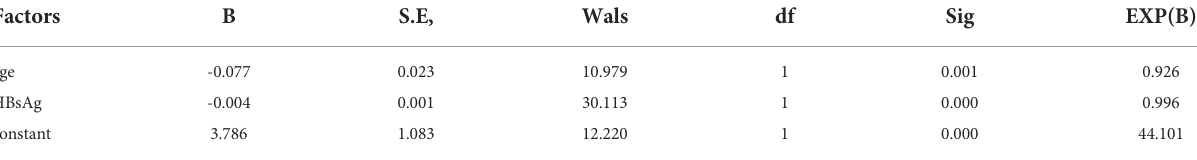
TABLE 4 Logistic regression analysis of week 48 HBsAg clearance in all patients.